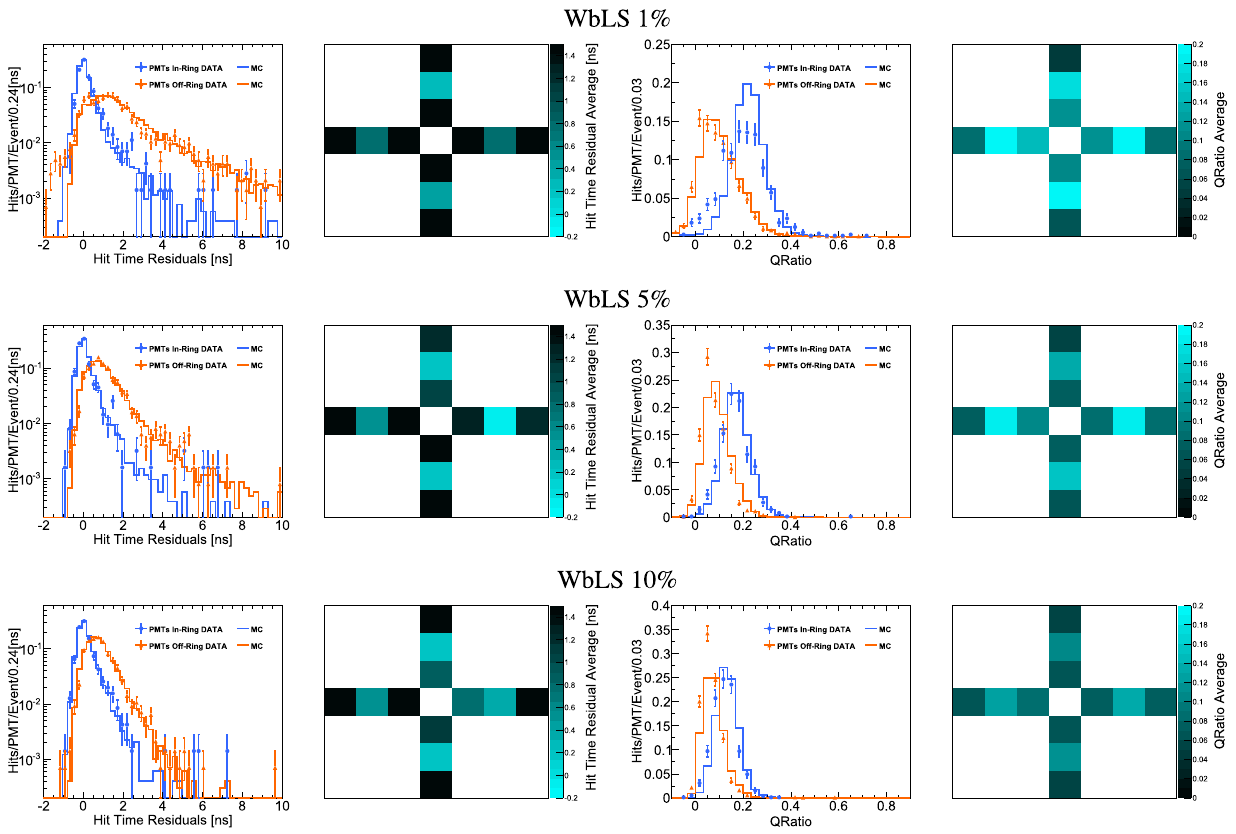
Fig. 6 Cherenkov/scintillation separation in hit-time residuals and charge ratio for (top) 1%, (middle) 5% and (bottom) 10% WbLS. (Left- most): PMT hit-time residual distributions for PMTs in the Cherenkov ring and outside it; (left-middle): PMT hit-time residuals vs PMT posi-